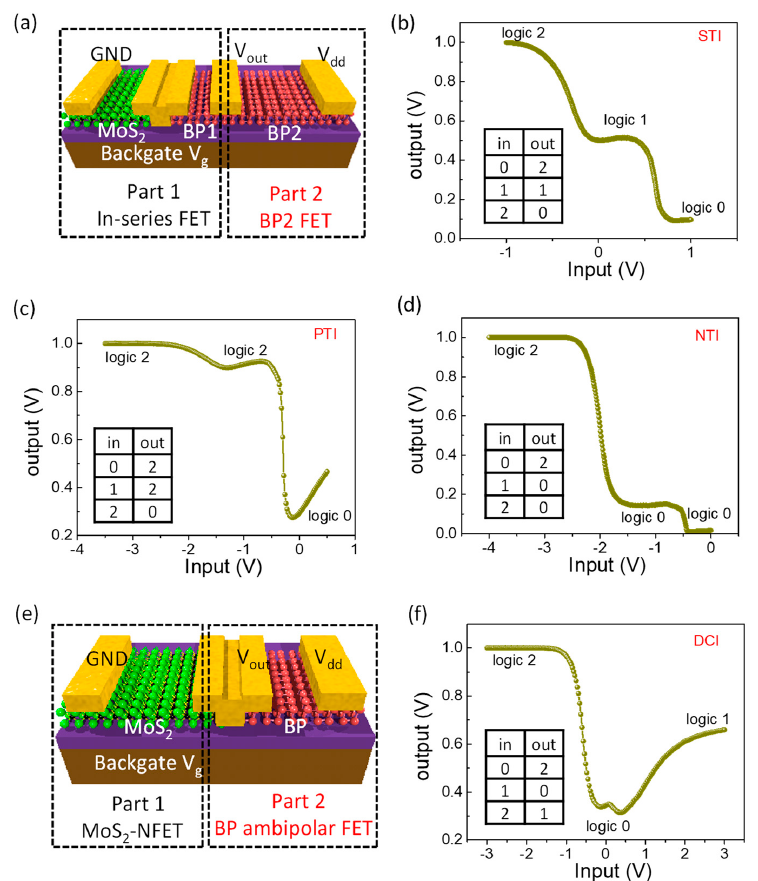
Figure 2. Demonstration of different ternary logic gates. ( a ) . Schematic view of a BP-MoS 2 standard ternary inverter. V out -V in characteristic curves of the ( b ) STI, ( c ) PTI and ( d ) NTI. ( e ). Schematic view of a BP-MoS 2 decrement cycling ternary inverter. ( f ). V out -V in characteristic curves of the DCI.